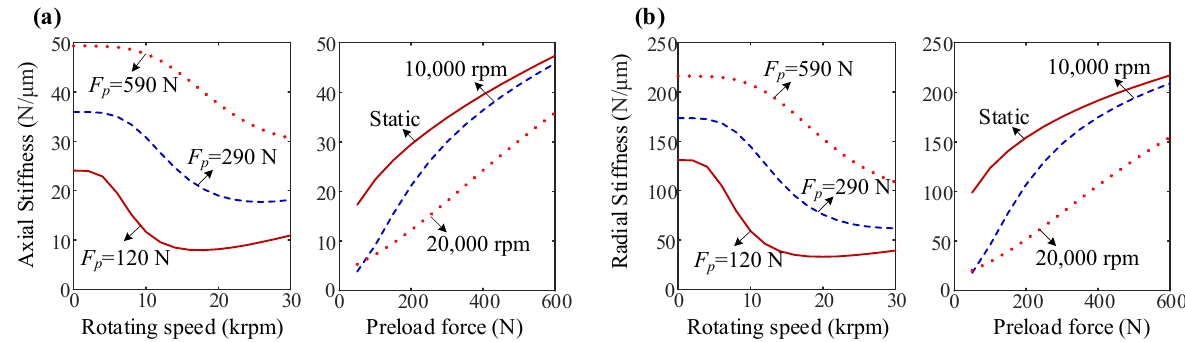
Figure 7. The influences of the rotating speed and axial preload on bearing stiffness (7008C): ( a ) bearing axial stiffness varies with speed and preload; ( b ) bearing radial stiffness varies with speed and preload.